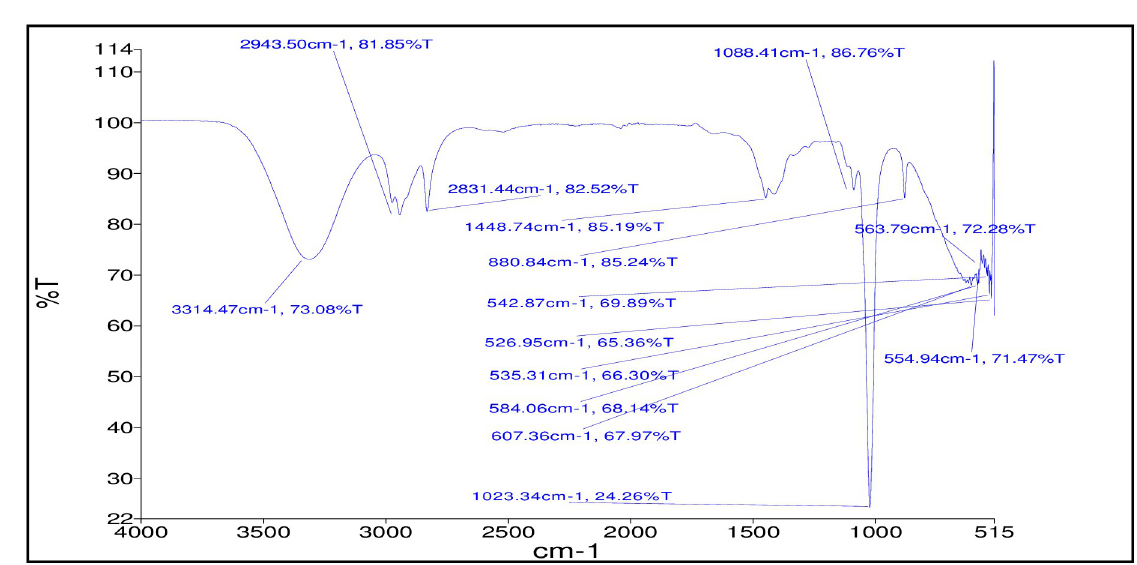
Fig 6. FT-IR spectra of ethanolic extract of M . piperita